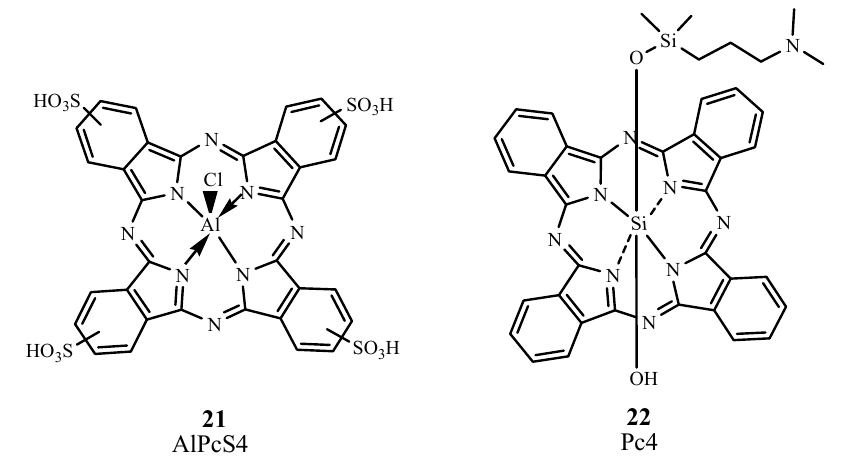
Figure 15. Examples of phthalocyanine PDT